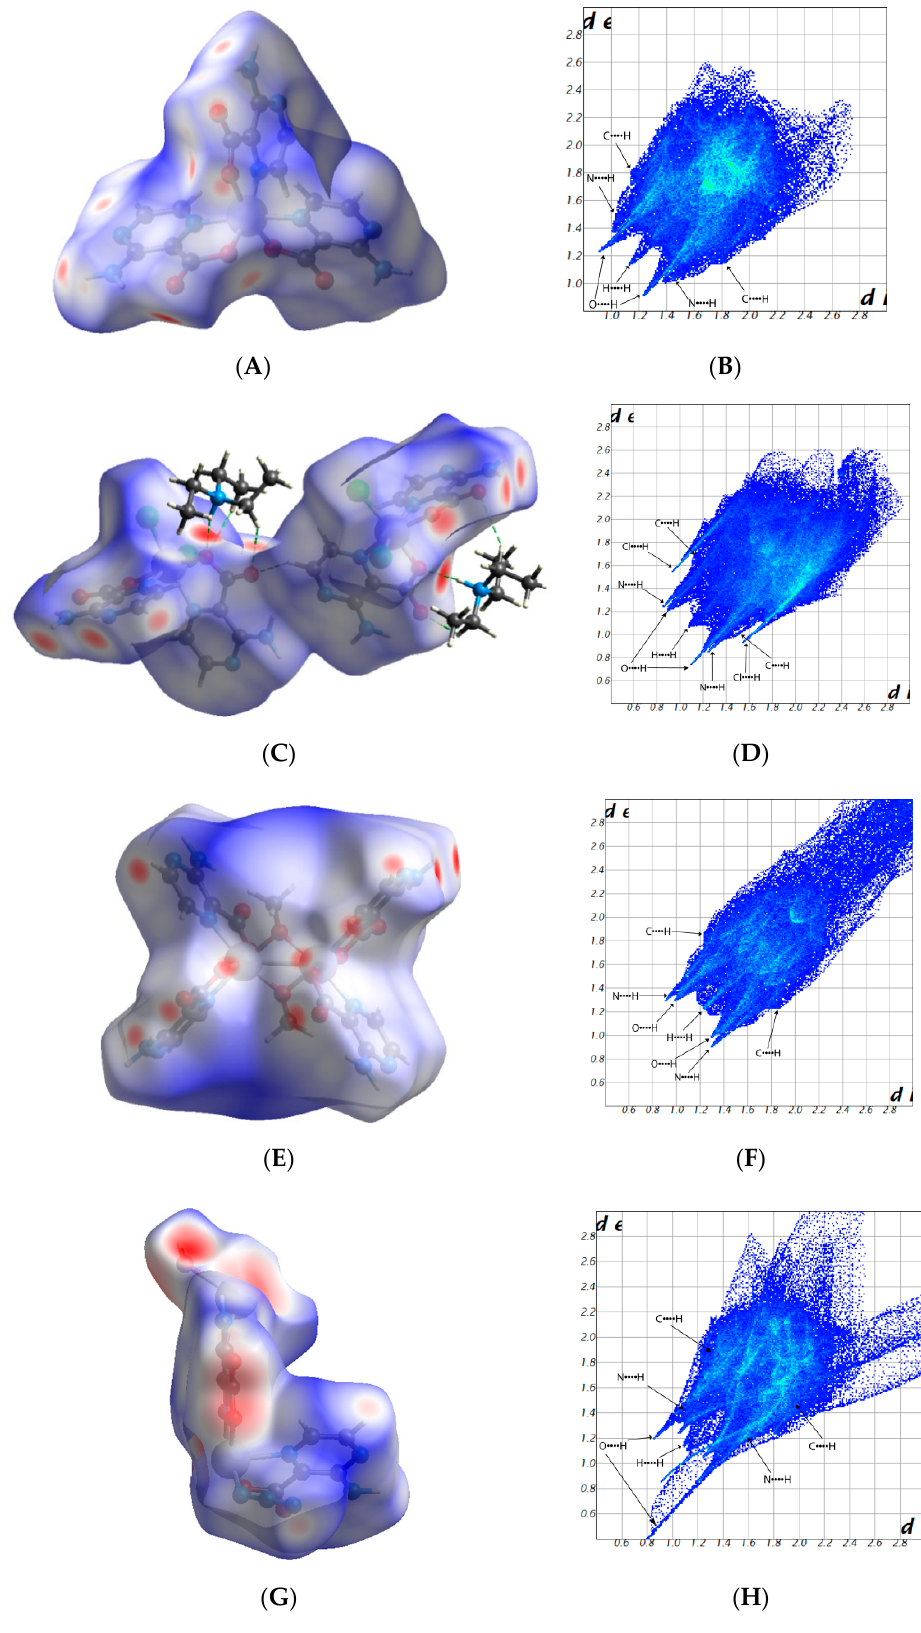
Figure 5. Calculated Hirshfeld surfaces of compounds 1 ( A ), 2 ( C ), 3 ( E ), and 4 ( G ). The red spots on the Hirshfeld maps correspond to close intermolecular interactions, whereas blue regions are the domains without close intermolecular contacts. 2D fingerprint plots of 1 ( B ), 2 ( D ), 3 ( F ), and 4 ( H ) exhibit different intermolecular interactions.